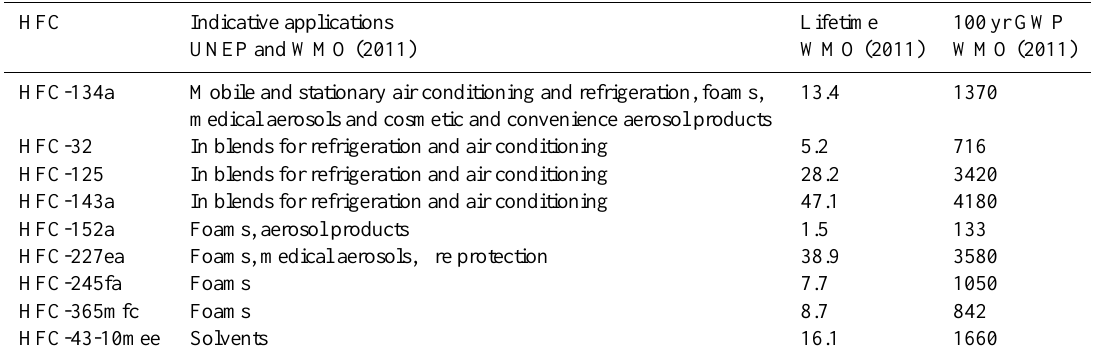
Table 1. Indicative applications using HFCs ∗ .